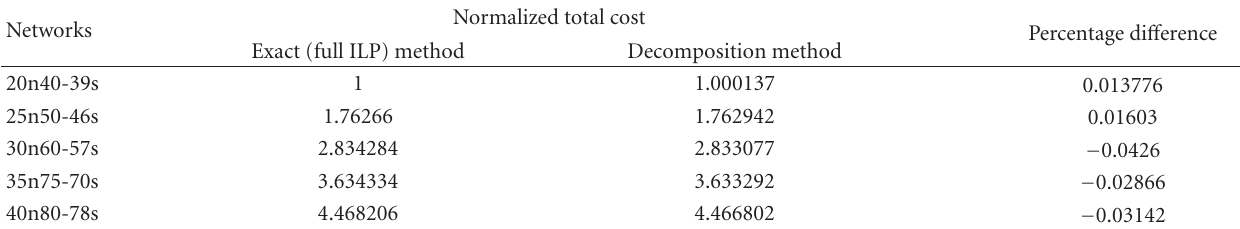
Table 1: Comparison of normalized total cost between decomposition method and exact